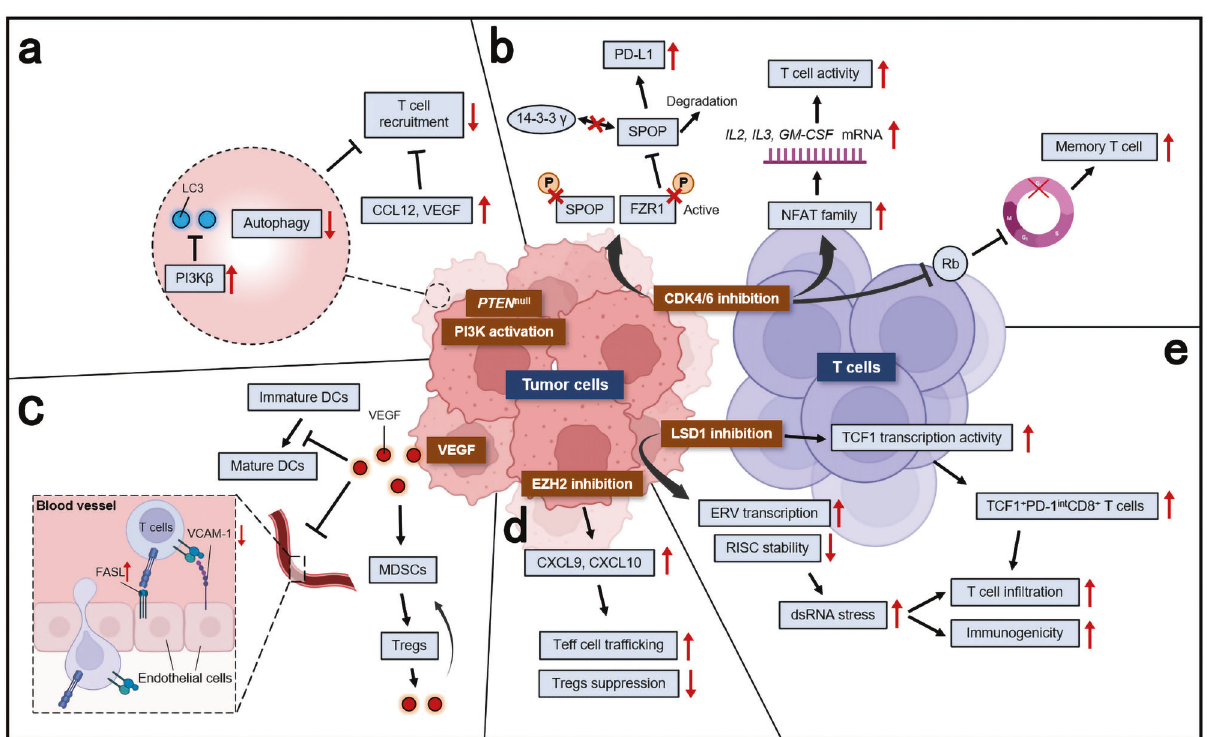
Fig. 6 Impact of oncogenic signaling on tumor immune response. a Loss of PTEN protein function and improper PI3K activation inhibit ef fi cient LC3 lipidation, which further promote resistance to T-cell-mediated killing by inhibiting autophagy. PTEN loss could also induce expression of immunosuppressive cytokines, including CCL12 and VEGF. b CDK4/6 inhibition enhances T-cell activation through the derepression of NFAT family proteins and their target genes, which encodes critical regulators of T-cell function. CDK4/6 inhibition could also induce Rb-mediated G1-arrest and promote the phenotypic and functional acquisition of immunologic T-cell memory. Besides, the PD-L1 protein stability is regulated by the CDK4-SPOP-FZR1 signaling pathway. Physiologically, PD-L1 protein stability is negatively regulated through phosphorylating its upstream physiological E3 ligase SPOP. This phosphorylation promotes SPOP binding to 14-3-3 γ , which subsequently disrupts FZR1-mediated destruction of SPOP. The inhibition of CDK4/6 inhibits the phosphorylation of SPOP, thus promoting its degradation by FZR1, thus increasing PD-L1 protein levels. c Tumor-derived VEGF limits NF- κ B activation in immature DCs, which in turn leads to defective functional maturation of DCs and insuf fi cient induction of tumor immunity. VEGF could also impact the endothelial cells expression of immunological molecules. It decreases the expression of VCAM-1, which is important for the antitumor T cells adhesion and in fi ltration into tumors. Besides, VEGF also increases the expression of FAS ligand on endothelial cells, triggering apoptosis of T cells. VEGF also promotes the expansion of immune suppressive MDSCs, which further promotes the recruitment of Tregs. d EZH2 inhibition increases the production of CXCL9 and CXCL10, which are attractant cytokines promoting traf fi cking of T cells to tumor. Besides, EZH2 inhibition could selectively target intratumeral Tregs and reduce its immunosuppressive capacity. e In tumor cells, the ablation of LSD1 in cancer cells increases repetitive element expression, including ERVs, and decreases expression of RISC components. This leads to dsRNA stress and activation of type 1 interferon, which stimulates antitumor T-cell in fi ltration. In addition, inhibiting LSD1 in CD8 + T cells unleashes the transcription program mediated by TCF1, which is critical for the maintenance of the progenitor subset of intratumoral CD8 + T cells for persistent tumor control. dsRNA double-stranded RNA, ERVs endogenous retroviral elements, MDSCs myeloid-derived suppressor cells, RISC RNA-induced silencing complex, TCF1 T-cell factor 1, VCAM-1 vascular cell adhesion